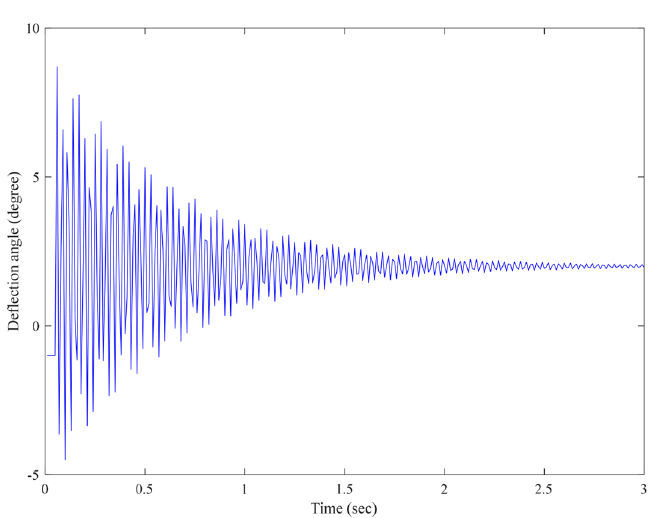
Figure 8. Open-loop step response of EMM disturbed by random